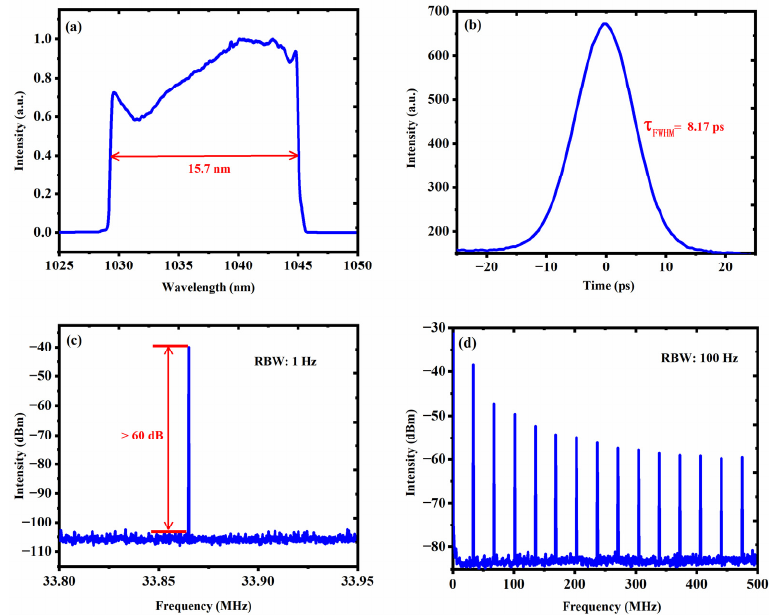
Figure 5. Output characteristics of dissipative solitons with a pulse width of 15.7 nm. ( a ) Optical spectrum. ( b ) Autocorrelation trace. ( c ) RF spectrum. ( d ) the RF spectrum with a span range of 500 MHz.